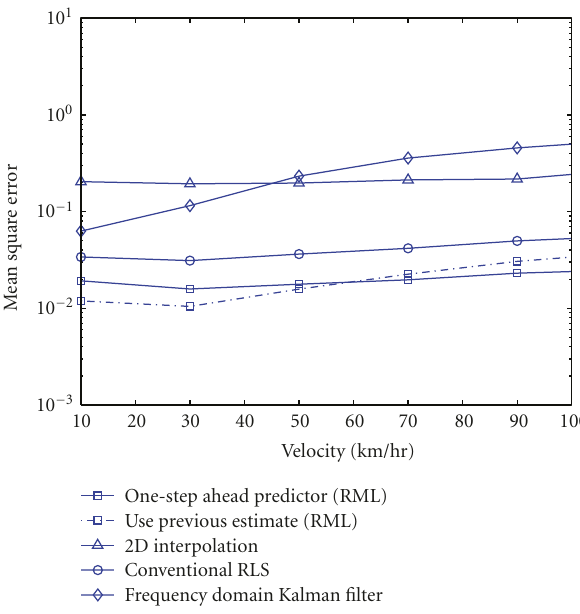
Figure 6: MSE of di ff erent channel-tracking methods as v = 60km/hr ( f d T = 0 . 0516) in urban area. Figure 7: MSE of channel tracking versus speed of